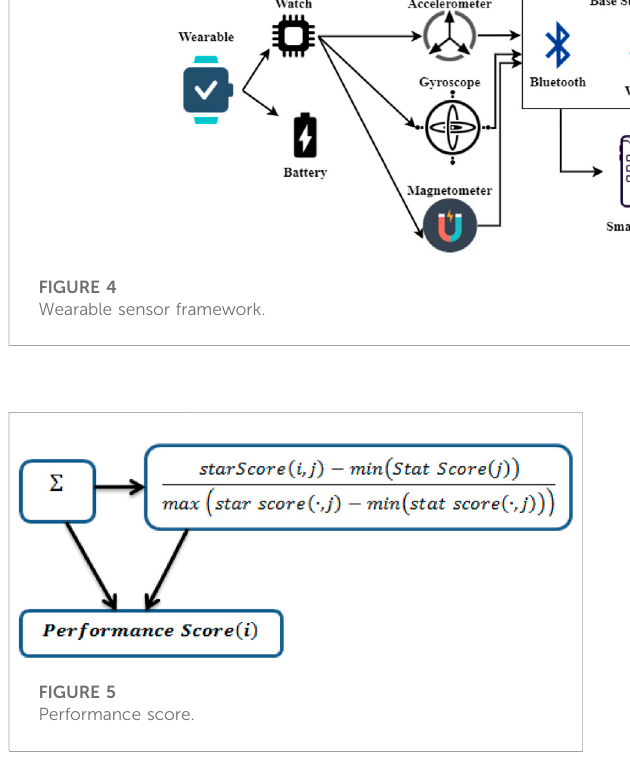
FIGURE 6 Softmax